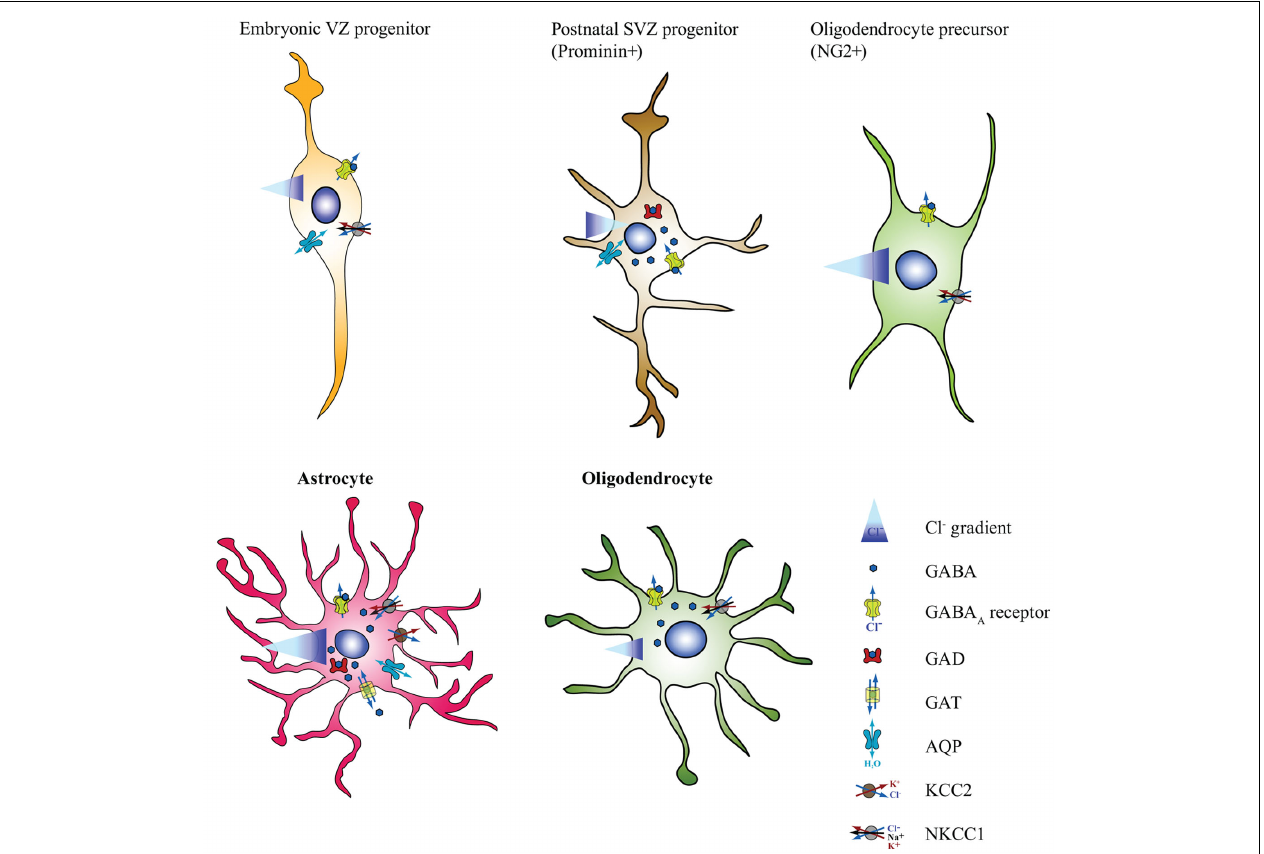
FIGURE 2 | GABA-mediated osmotic regulation in non-neuronal cells. Schematic representation summarizing the current knowledge concerning the expression of the neurotransmitter GABA, the synthesizing enzyme GAD, the membrane transporter GAT, which can work in both directions, and the ionic GABA A R in the indicated non-neuronal cell types of the mammalian CNS. Depicted is also the direction of water flux and of the Cl − gradient, as estimated in resting physiological conditions.The scheme also illustrates the expression of the aquaporin (AQP) water channels and of the Na + /K + /Cl − (NKCC) and K + /Cl − (KCC) transporters in those cell types where their expression has been directly investigated. As in neurons, GABA promotes swelling in neural stem cells (NSC) but not in NG2 + oligodendrocyte